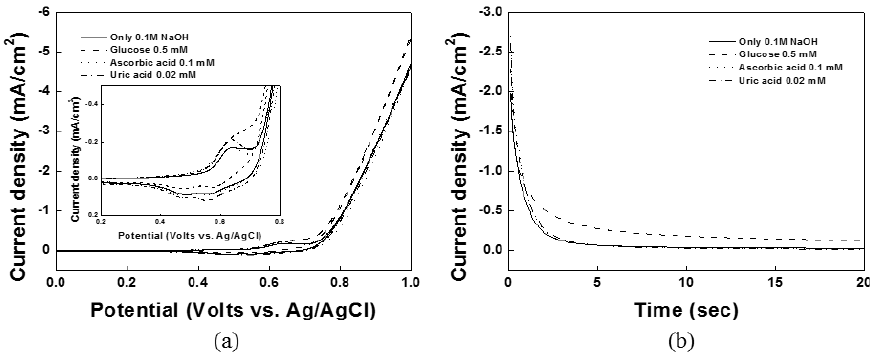
Figure 5. ( a ) Cyclic voltametric and ( b ) chronoamperometric response of glucose in the presence of 0.02 mM UA and 0.1 mM AA at DSPNCE in 0.1 M NaOH at 0.65 V vs. Ag/AgCl.